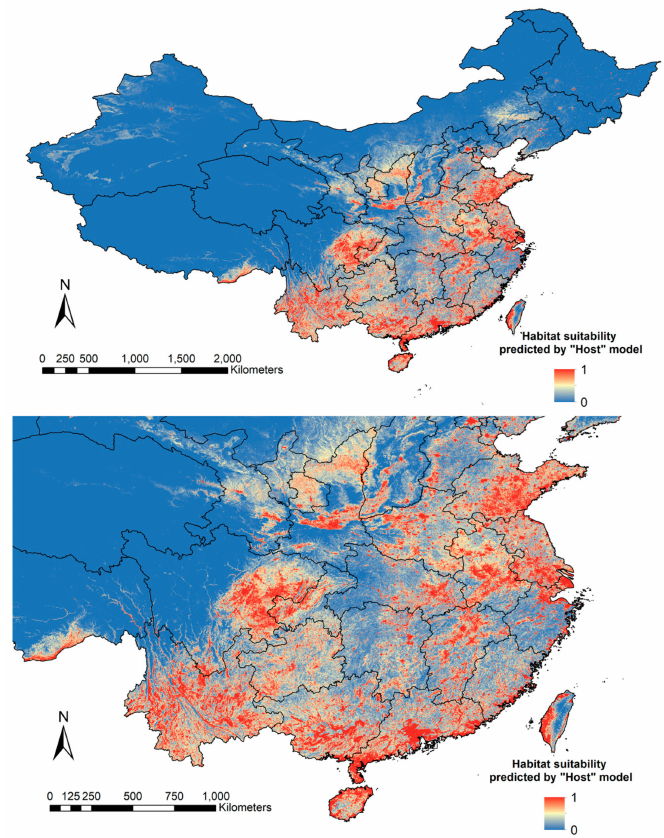
Figure 2. Distribution prediction map of Cx. tritaeniorhynchus based on the “Host” model. Prediction of habitat suitability of Cx. tritaeniorhynchus by using layers including human population density and pig density (the “Host” model, n =